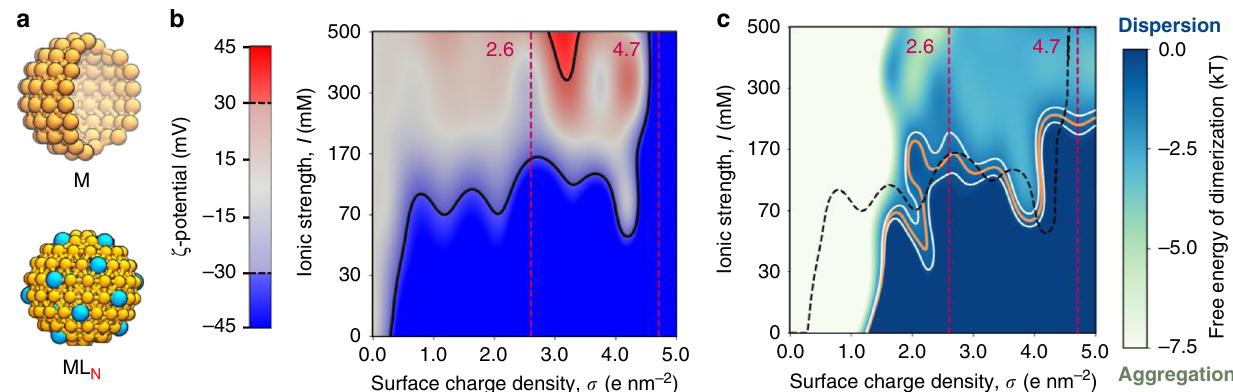
Fig. 2 Dispersion state phase diagrams of ion-capped metallic NPs. a Coarse-grained models of pristine (M, top) and capped (ML N , bottom) NPs for the construction of the phase diagrams. The cyan beads implicitly account for grafted ligands with a charge of − 2 e. b The relation between the NP surface charge density ( σ ), the environment ionic strength ( I ), and the computed ζ -potential. The black contour demarcates the region where the ζ -potential lies between − 30 and + 30 mV. The opaque blue and red regions indicate the conditions where the ζ -potential computations suggest colloidal stability. c Map of the NPs free energy of dimerization for the various studied systems. The orange and white curves outline the region where the free energy is − 1.0 ± 0.5 kT. The black contour drawn for the ζ -potential is superimposed onto this plot. The dark blue and light green colors indicate the conditions at which the free energy calculations suggest colloidal stability and aggregation, respectively. The dashed, red lines indicate the limiting values of σ for citrate-capped NPs as determined by the developed theoretical